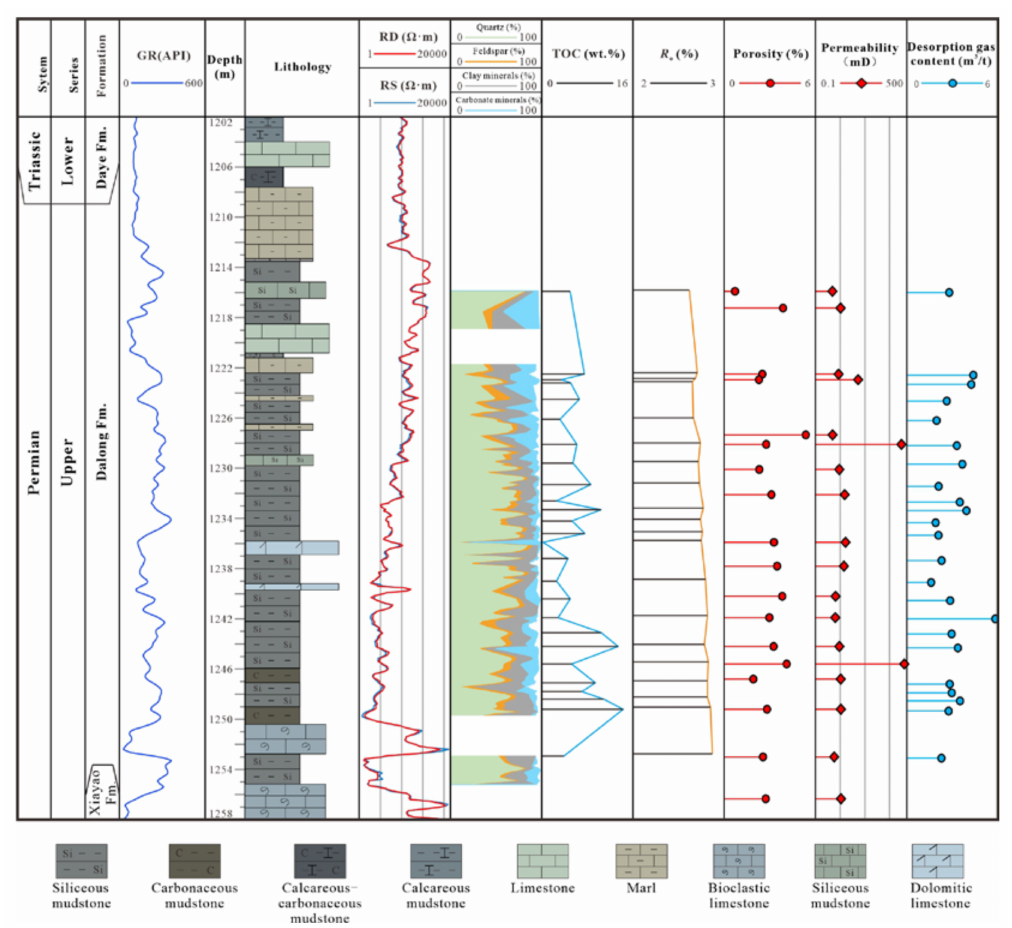
Figure 2. Comprehensive stratigraphic column of the upper Permian Dalong Formation in well